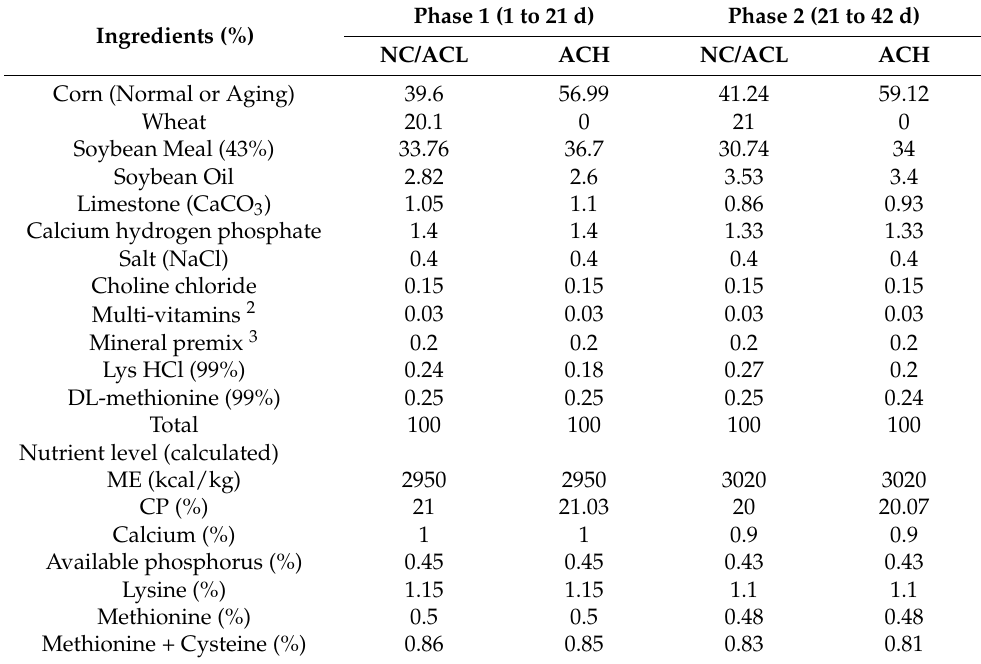
Table 1. Formulation of basal diets 1 fed to broilers during Phases 1 and 2. Phase 1 (1 to 21 Ingredients (%)